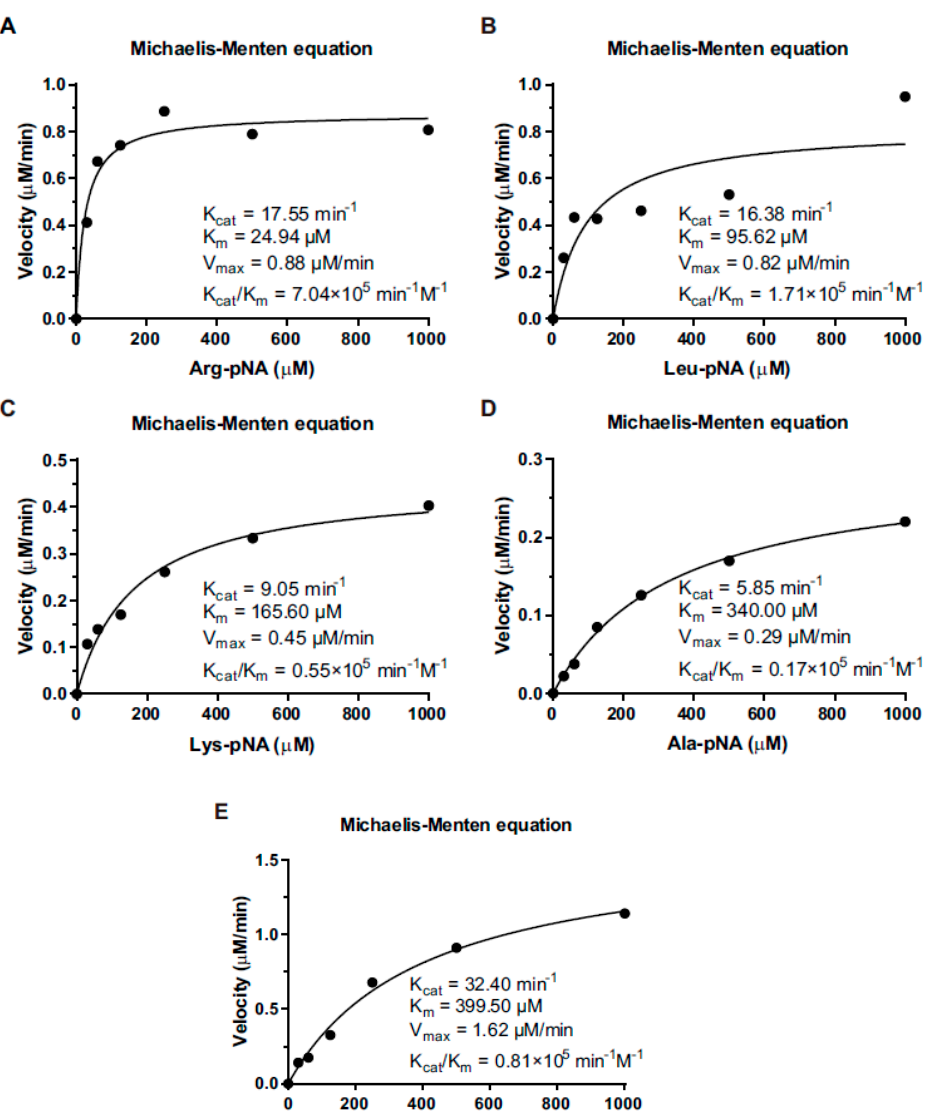
Figure 3. The Michaelis–Menten kinetic parameters of LmAmpII. The Michaelis–Menten curves of LmAmpII were plotted, and the K m , V max , K cat , and K cat / K m values were determined for each substrate. ( A ) Arg- p NA, ( B ) Leu- p NA, ( C ) Lys- p NA, ( D ) Ala- p NA, or ( E ) Phe- p NA. These assays were carried out using the specific substrate at a concentration range of 0–1000 µ M in 25 mM Tris-HCl (pH 7.4), containing 0.05 µ M enzyme. Data of each black dot shown represent mean ± SD.